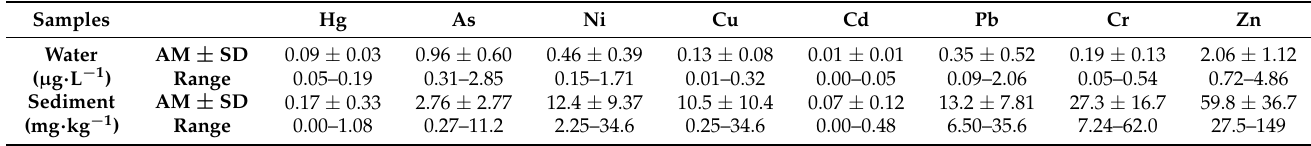
Table 3. Average content of trace metals of water environment.